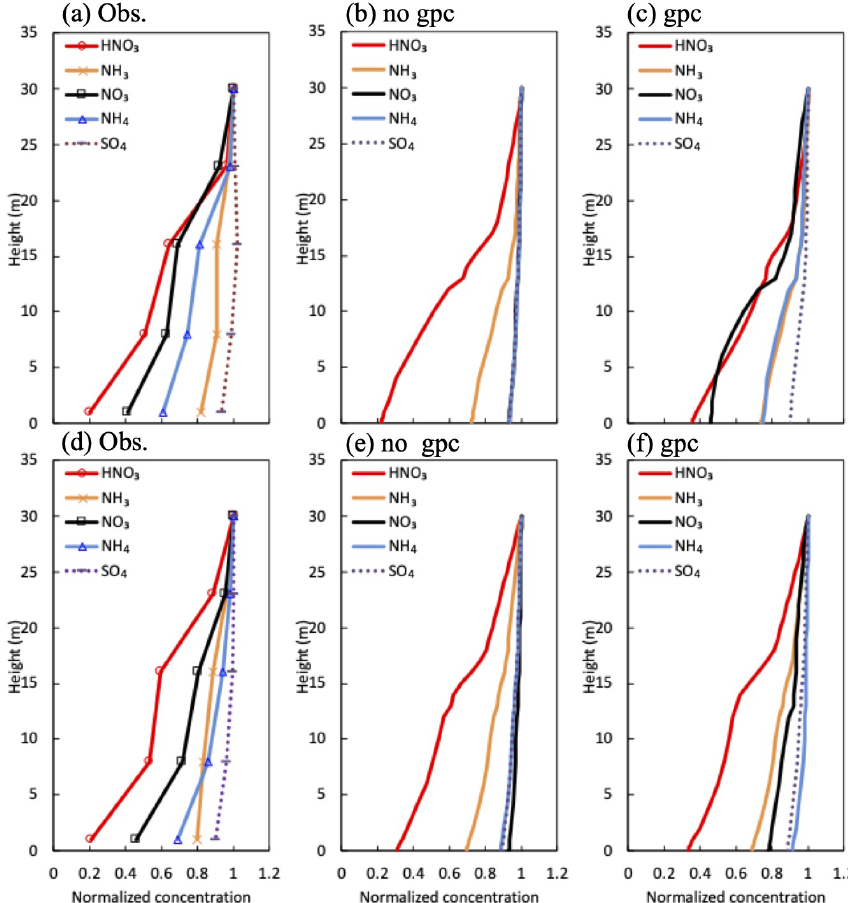
Figure 7. Mean vertical profiles in (a) observed and (b) calculated normalized mass concentration in the scenario of no gpc and (c) the scenario of gpc for HNO 3 and NH 3 gases and SO 2 − 27 September and 11 October